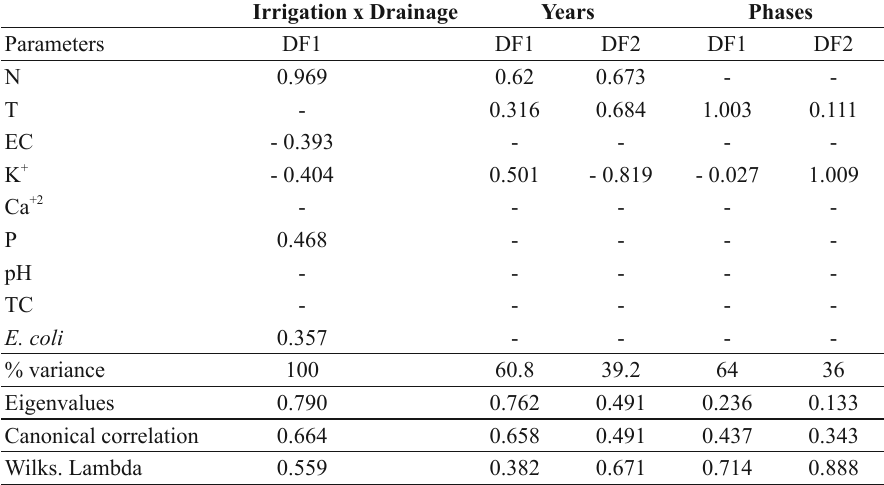
Matrix standardized coef fi cient, percentage of variance, eigenvalues, canonical correlation, and Wilks lambda for discriminant analysis variation in quality of irrigation and drainage water in